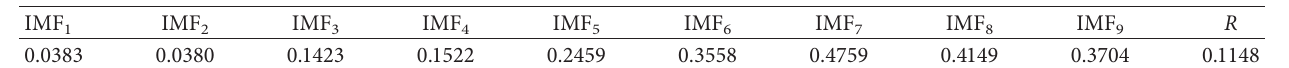
Figure 8: Decomposed IMFs of the original signal using the ESMD method. Table 3: Spearman’s rho of the IMFs and R .